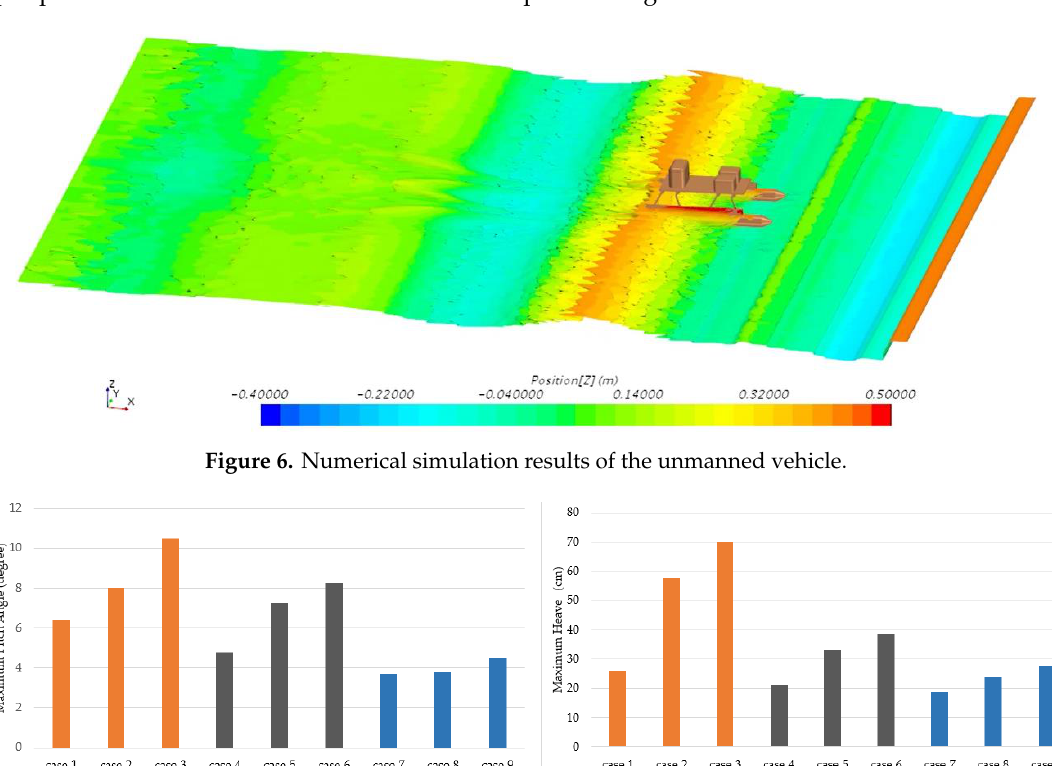
( d ) Figure 5. Electronic navigation Chart and Grid Depth Distribution Map. ( a ) S57 Vector Electronic navigation Chart displayed by S52 Standard in the study area; ( b ) Isobath Area Map; ( c ) Depth Distribution Map obtained by spline function interpolation approach with obstacles, in which the blank area is an obstacle; ( d ) Overlay with discrete depth points, contours, islands and reefs and other obstacles. In the depth distribution map, the magenta area is an obstacle. 3. Depth Safety Path Planning Method 3.1. Analysis of Hydrodynamic Properties of Unmanned Surface Vehicle According to the hydrodynamic model established in Section 2.1, the navigation simulation of the USV is carried out, and the hydrodynamic properties of the USV under nine different working conditions are analyzed. The numerical simulation results are shown in Figures 6 – 8. The diagrams of navigation status, including heave and pitch motion in time domain under nine working conditions, are detailed in Supplementary Materials Figures S1 and S2. As shown in Figure 7a, the heave motion of the unmanned surface vehicle presents a gentle trend with the increase of speed. As shown in